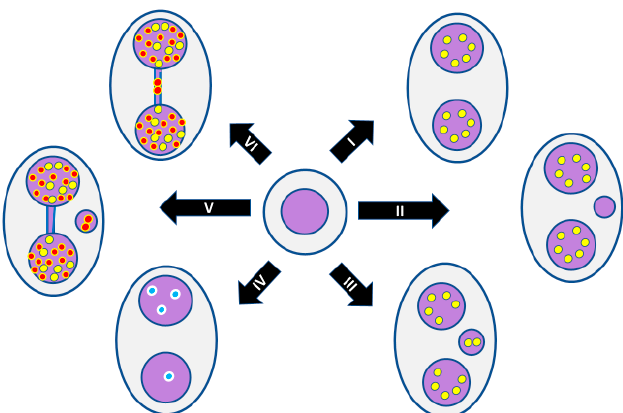
Figure 5. Use of molecular probes in the CBMN cytome assay to understand mechanisms: ( I ) normal binucleated (BN) cell; ( II ) BN cell containing one micronucleus originating from an acentric chromosome fragment; ( III ) BN cell containing one micronucleus originating from a mal-segregated whole chromosome; ( IV ) Mal-segregation of a chromosome in a BN cell without a micronucleus, which is evident because of unequal distribution of chromosome-specific peptide nucleic acid (PNA) probe signals; ( V ) BN cell with a nucleoplasmic bridge and micronucleus originating from a dicentric chromosome and an acentric chromosome fragment as a result of mis-repair of DNA strand breaks; ( VI ) BN cell with a nucleoplasmic bridge only, originating from a dicentric chromosome as a result of fusion of the telomeres of two chromosomes. Yellow dots represent signals observed using pancentromeric PNA probes. Red dots represent signals observed using telomere PNA probes. Blue dots represent signals observed using a PNA probe specific to only one chromosome. For the sake of simplicity, the conceptual diagrams only show a representative fraction of chromosomes.